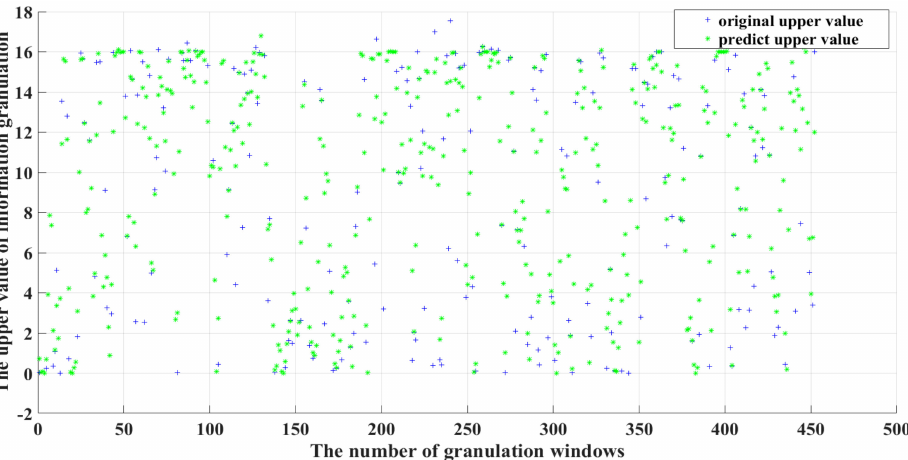
Figure 10. The prediction effect of the upper